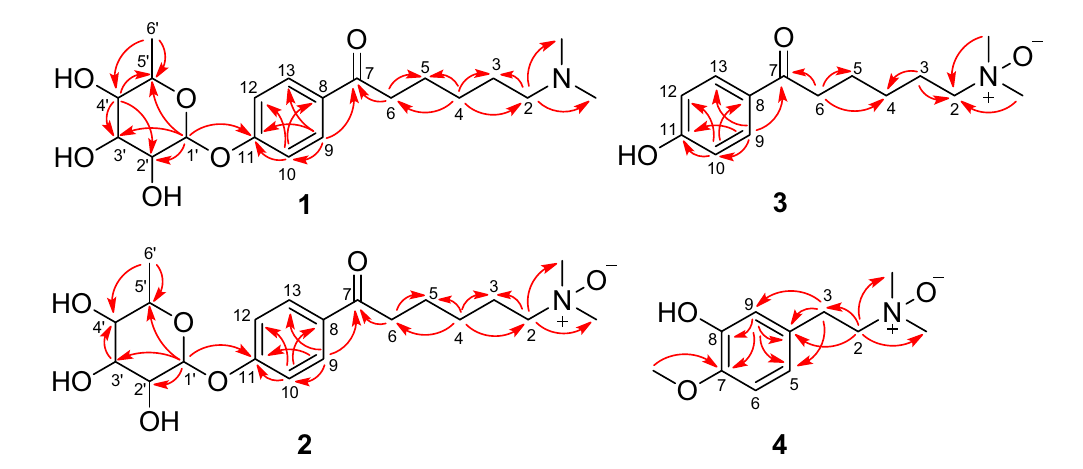
Fig. 2 Key HMBC (H → C) correlations of compounds 1 –